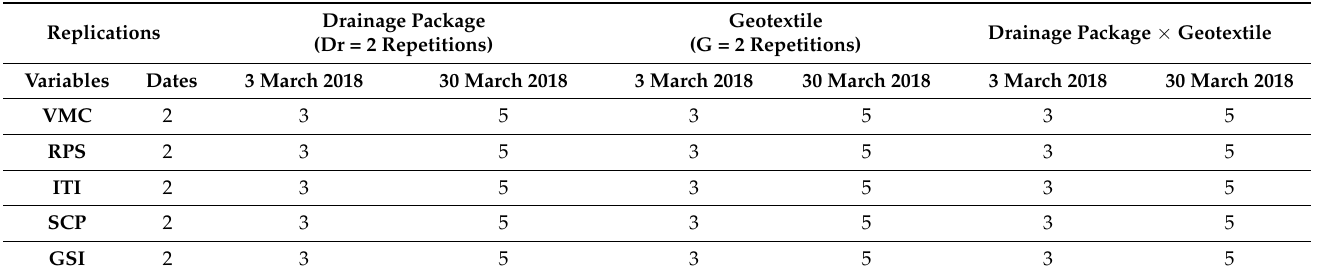
Table 1. Replications of treatments and variables from tools used in the experiment on both